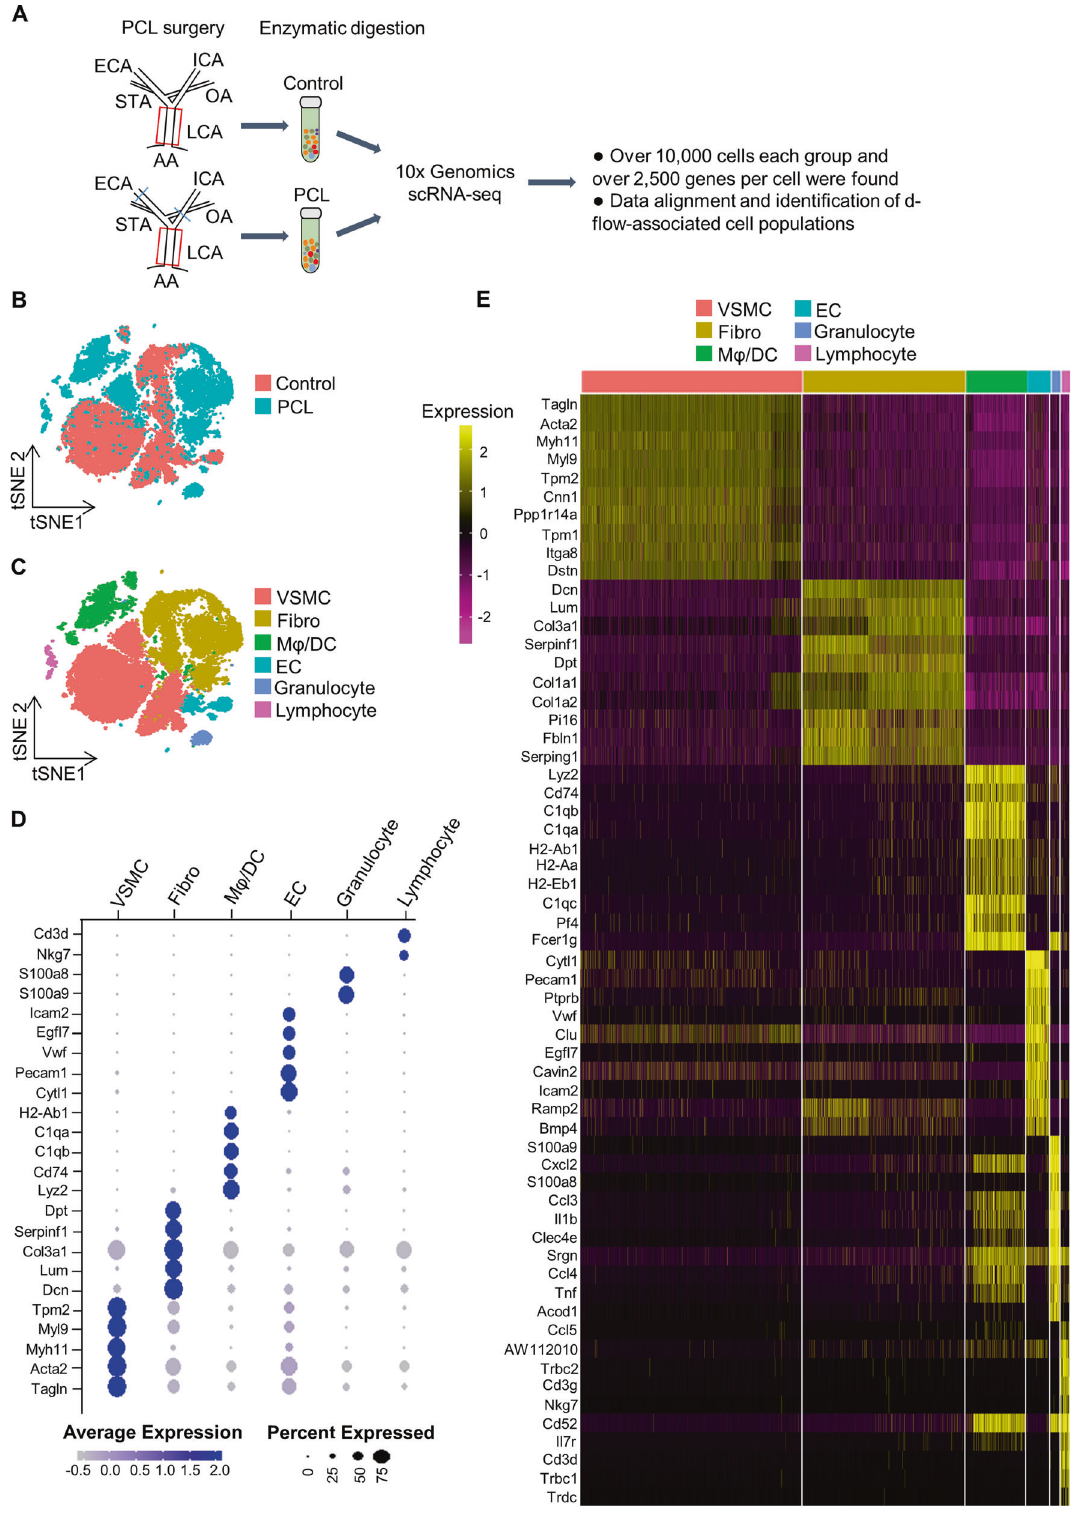
Fig. 1 Single-cell RNA-sequencing (scRNA-seq) atlas of left carotid artery cell types. A Schematic overview of experimental design. B t- distributed stochastic neighbor embedding (t-SNE) represents the aligned gene expression data in single cells extracted from the left carotid artery of wild-type mice 7 days after partial carotid ligation (PCL) surgery or without PCL (control). C t-SNE representation of single-cell gene expression shows the identi fi ed major left carotid artery cell types. D The top markers de fi ning each type of cell cluster in C are listed. The size of each circle represents the proportion of cells within the group expressing each transcript. The blue color dots indicated highly expressed genes, while gray color dots correspond to low expressed genes. E The heatmap showing the 10 most upregulated genes in each cluster de fi ned. ECA external carotid artery, ICA internal carotid artery, OA: occipital artery, STA superior thyroid artery, LCA left carotid artery, AA aortic arch, EC endothelial cells, VSMC vascular smooth muscle cells, fi bro fi broblasts, M φ /DC macrophages and dendritic cells. Cell Death Discovery (2021)